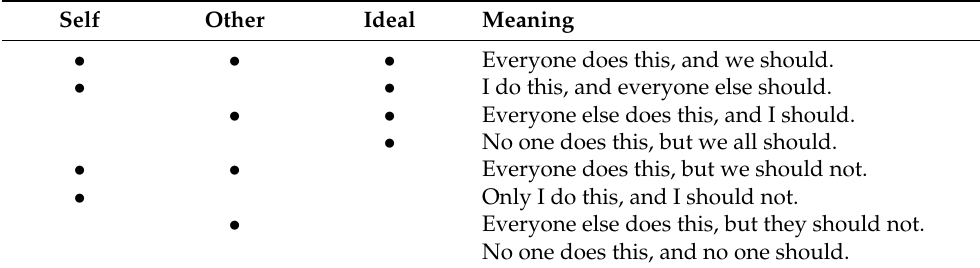
Table 2. Interpretations of indications of self, others, and ideal